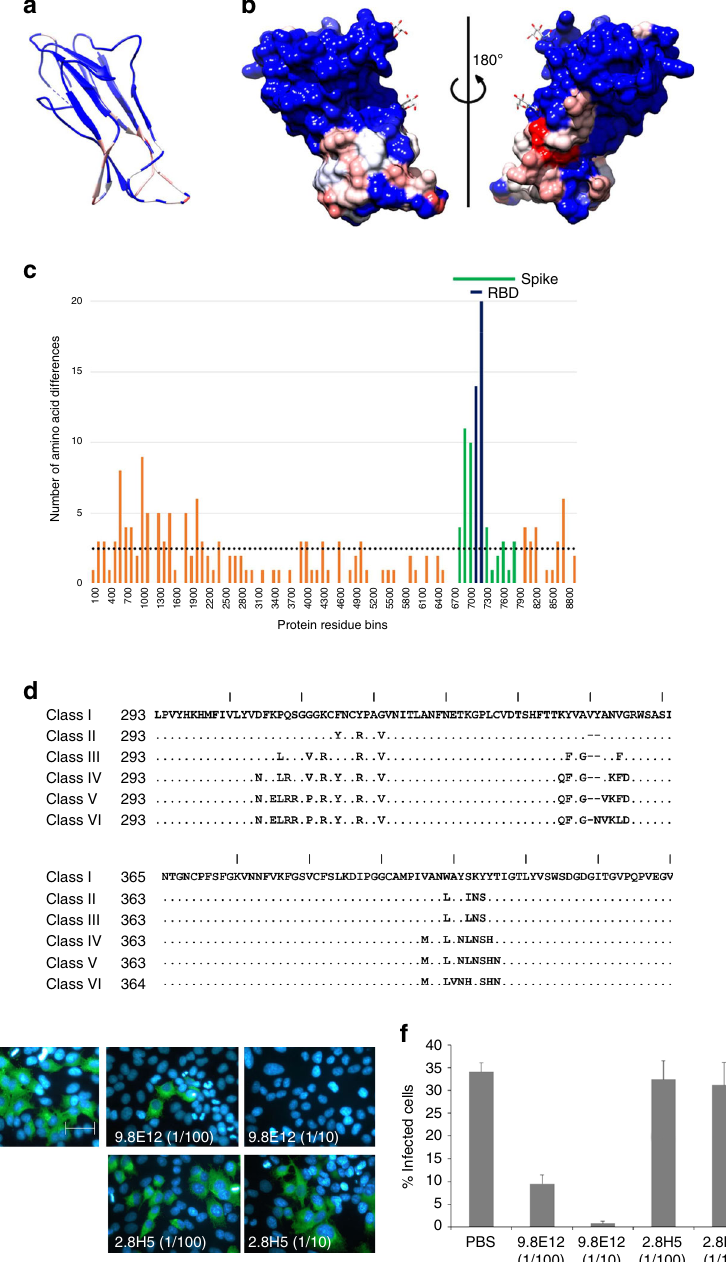
Fig. 4 Naturally occurring HCoV-229E sequence variation. a Color-coded amino-acid sequence conservation index (Chimera) mapped onto a ribbon representation of the HCoV-229E RBD. Blue represents a high percentage sequence identity and red represents a low percentage sequence identity among the 52 viral isolates analyzed. b Surface representation in the same orientation as in ( a , left), and rotated 180° (right). The Asn-GlcNAc moiety of the N - glycans are shown in stick representation. Color coding as in a . c Amino-acid sequence variation shown by the eight viral isolates whose entire genome sequences have been reported. The entire protein coding region of the viral genome was treated as a continuous amino acid string (8850 residues in total). Amino acid differences among the eight sequences were analyzed in 100 residue bins and for each bin the sum was plotted. Green-colored bins correspond to residues in the S-protein and purple-colored bins correspond to residues in the RBD. The horizontal dotted line denotes the average number of amino- acid differences per bin across the protein-coding region of the whole viral genome. d Alignment of the sequences selected for each of the six classes. The “ | “ symbol demarcates every 10 residues in the alignment. e Representative images showing HCoV-229E infection of L-132 cells in the presence of: PBS, monoclonal antibody 9.8.E12 at two different concentrations, and monoclonal antibody 2.8H5 at two different concentrations (anti-HCoV-OC43 antibody). The nucleus is stained blue and green staining indicates viral infection. Magni fi cation (×200) and scale bar = 10 µ m. f Statistical quanti fi cation of the monoclonal antibody inhibition experiment. Error bars correspond to standard deviations obtained from three independent